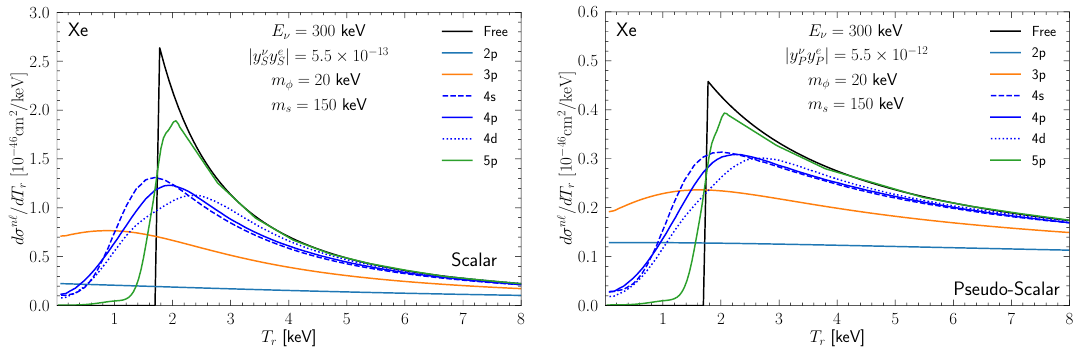
Figure 4 . The differential cross section of ν - e scattering with a massive sterile neutrino in the final state and light scalar (left) or pseudo-scalar (right) mediator. The black line is for the scattering with a free electron while the colorful lines are for the bound electrons 2 p (solid cyan), 3 p (solid yellow), 4 s (dashed blue), 4 p (solid blue), 4 d (dotted blue), and 5 p (solid green) of a Xenon atom. In both subplots, the final-state sterile neutrino mass is m s = 150 keV and the mediator mass is m φ = 20